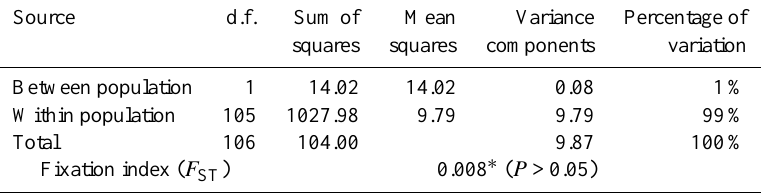
Table 4. Partitioning of molecular variance within and between Sudanese camel populations and the level of population substructuring ( F ST ). Source